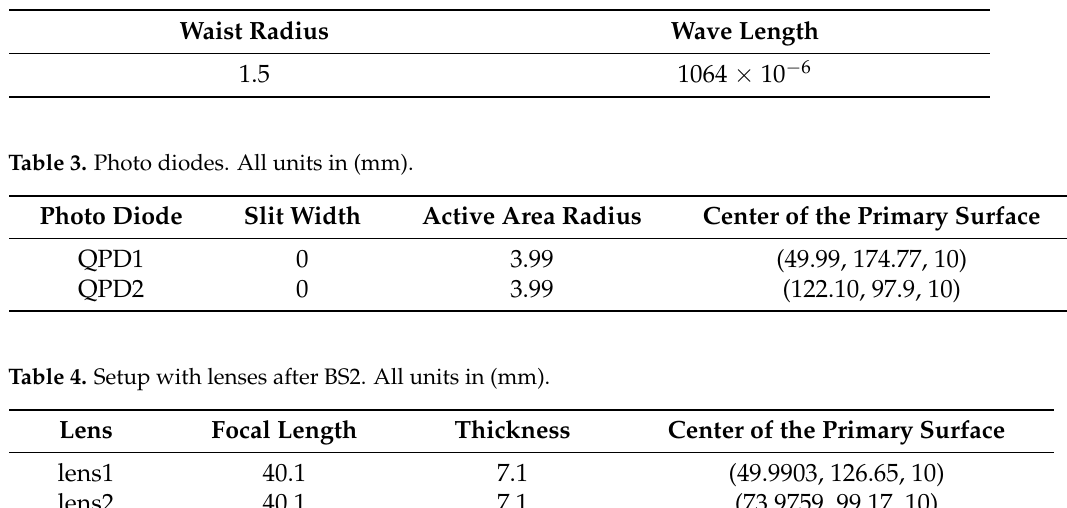
Table 2. Input Laser Beam. All units in (mm).